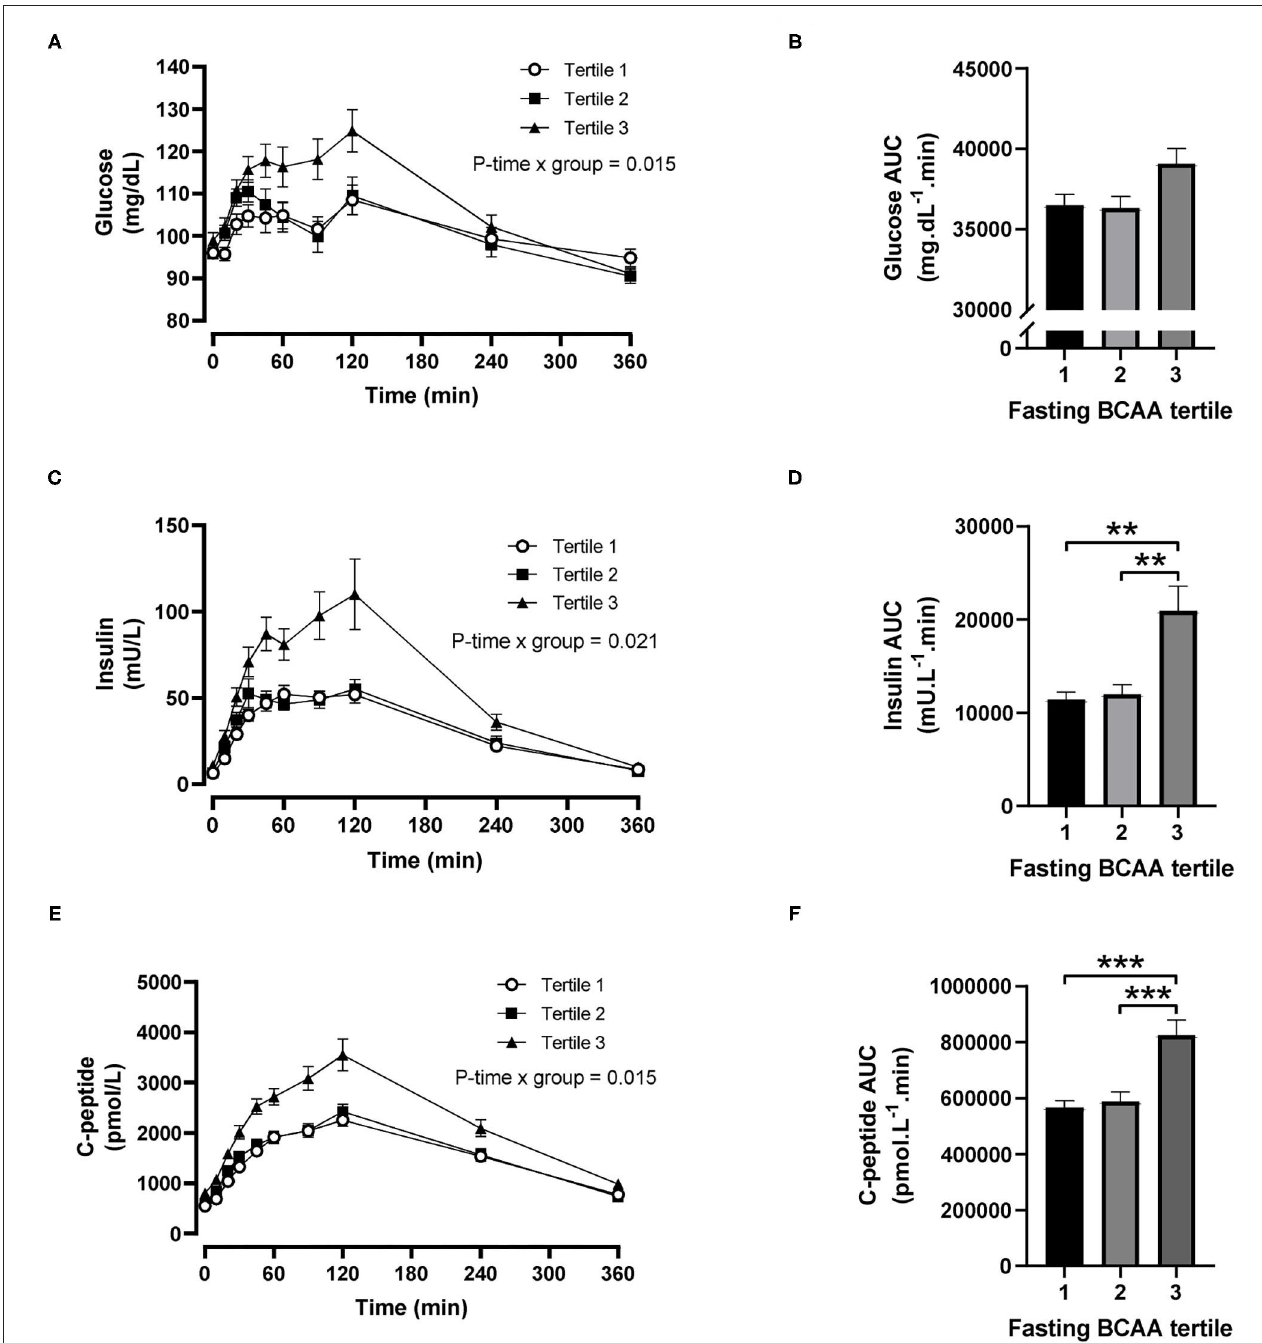
FIGURE 2 | Time courses and areas under the curve (AUC) of plasma glucose, insulin and C-peptide after ingestion of a mixed meal in subjects stratified in fasting branched-chain amino acid (BCAA) concentration tertiles. Glucose (A,B) , insulin (C,D) and C-peptide (E,F) concentrations (linear mixed model) and AUCs (one-way ANOVA) after ingestion of a liquid mixed meal by fasting BCAA concentration tertiles. Data are mean ± SEM; n = 30–33 per group. All analyses have been adjusted for sex and BMI. Corresponding values are significantly different between groups (Šidák-corrected): ** P < 0.01, *** P < 0.001.